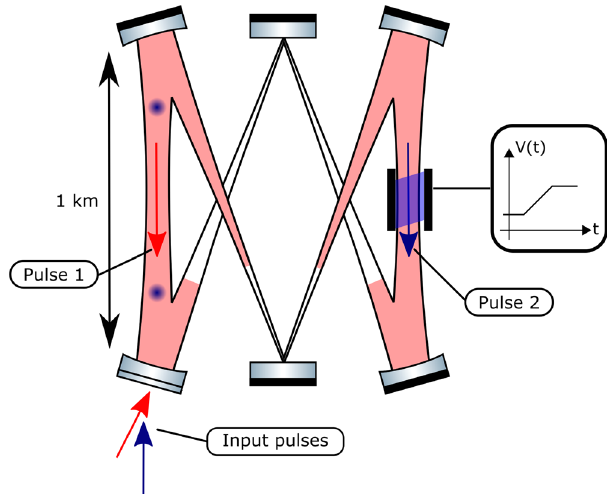
Fig. 1 Circulating pulse interferometry schematic. Circulating pulses occupy each of the two running wave modes in this example cavity, 6 km round trip with a 1 km baseline aligned with gravity. On each round trip, additional light is coupled into the cavity to compensate for losses. Serrodyne modulation, applied through a Pockels cell, shifts the frequency of each pulse on each pass to compensate for Doppler shifts. The pulse durations are maximized within the constraint that only one pulse may pass through the atoms (blue) or Pockels cell at a